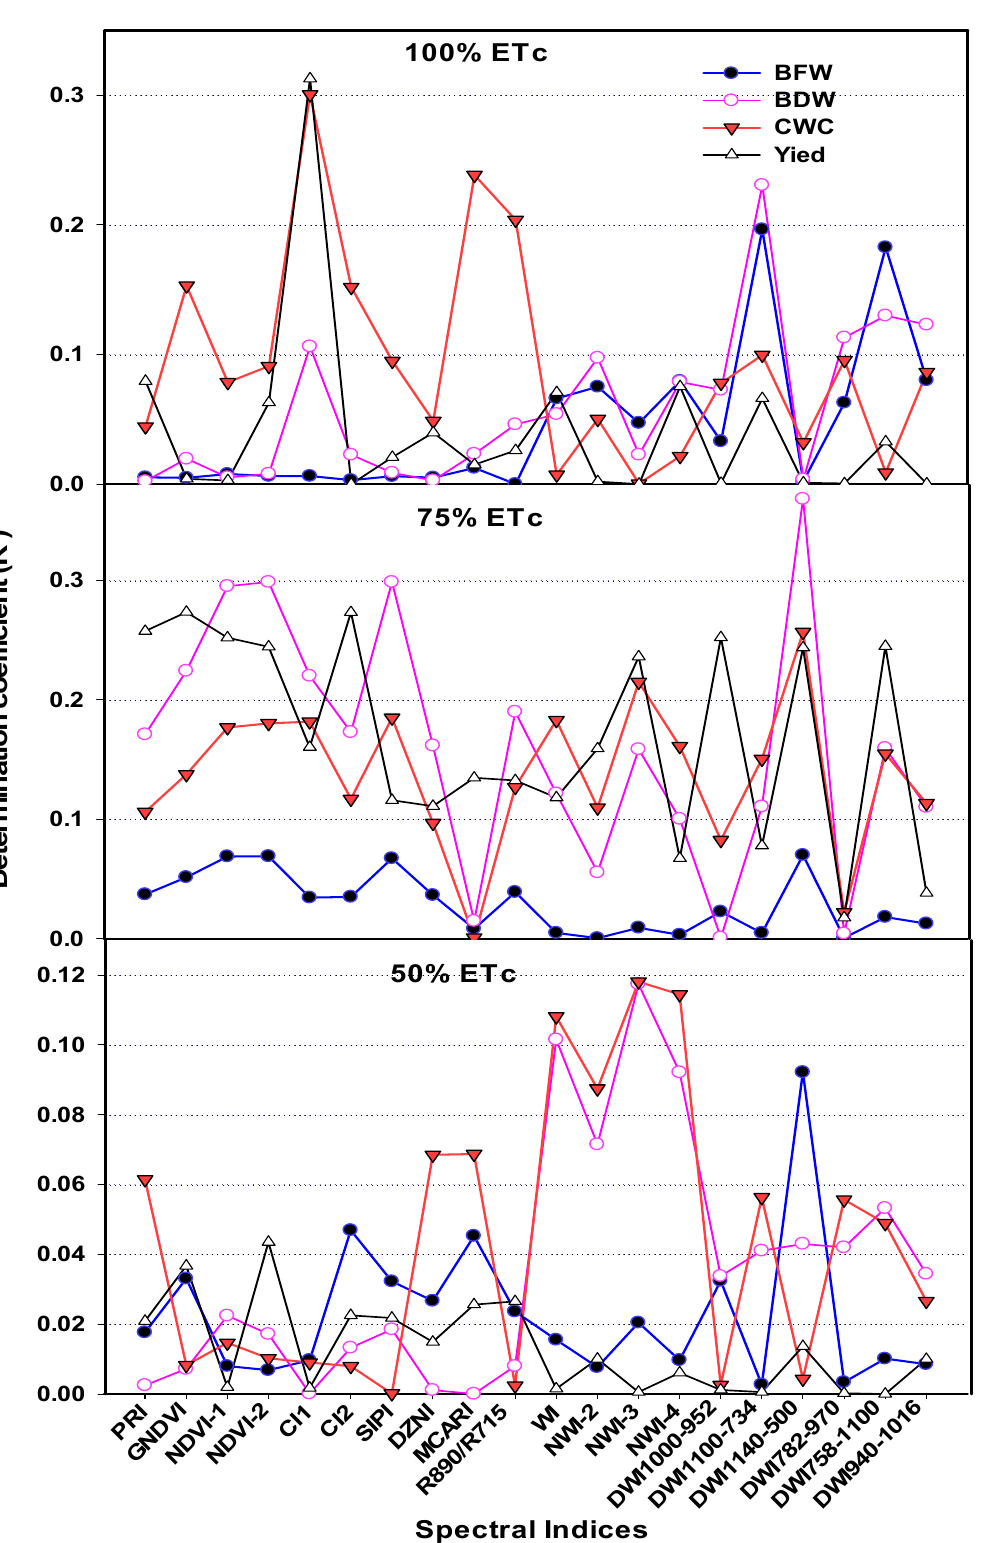
Figure 6. Coefficients of determination (R 2 ) for the relationship between selected SRIs and biomass fresh weight (BFW), biomass dry weight (BDW) canopy water content (CWC) and total tuber yield (TTY) under 100%, 75%, and 50% ETc ( n = 16).